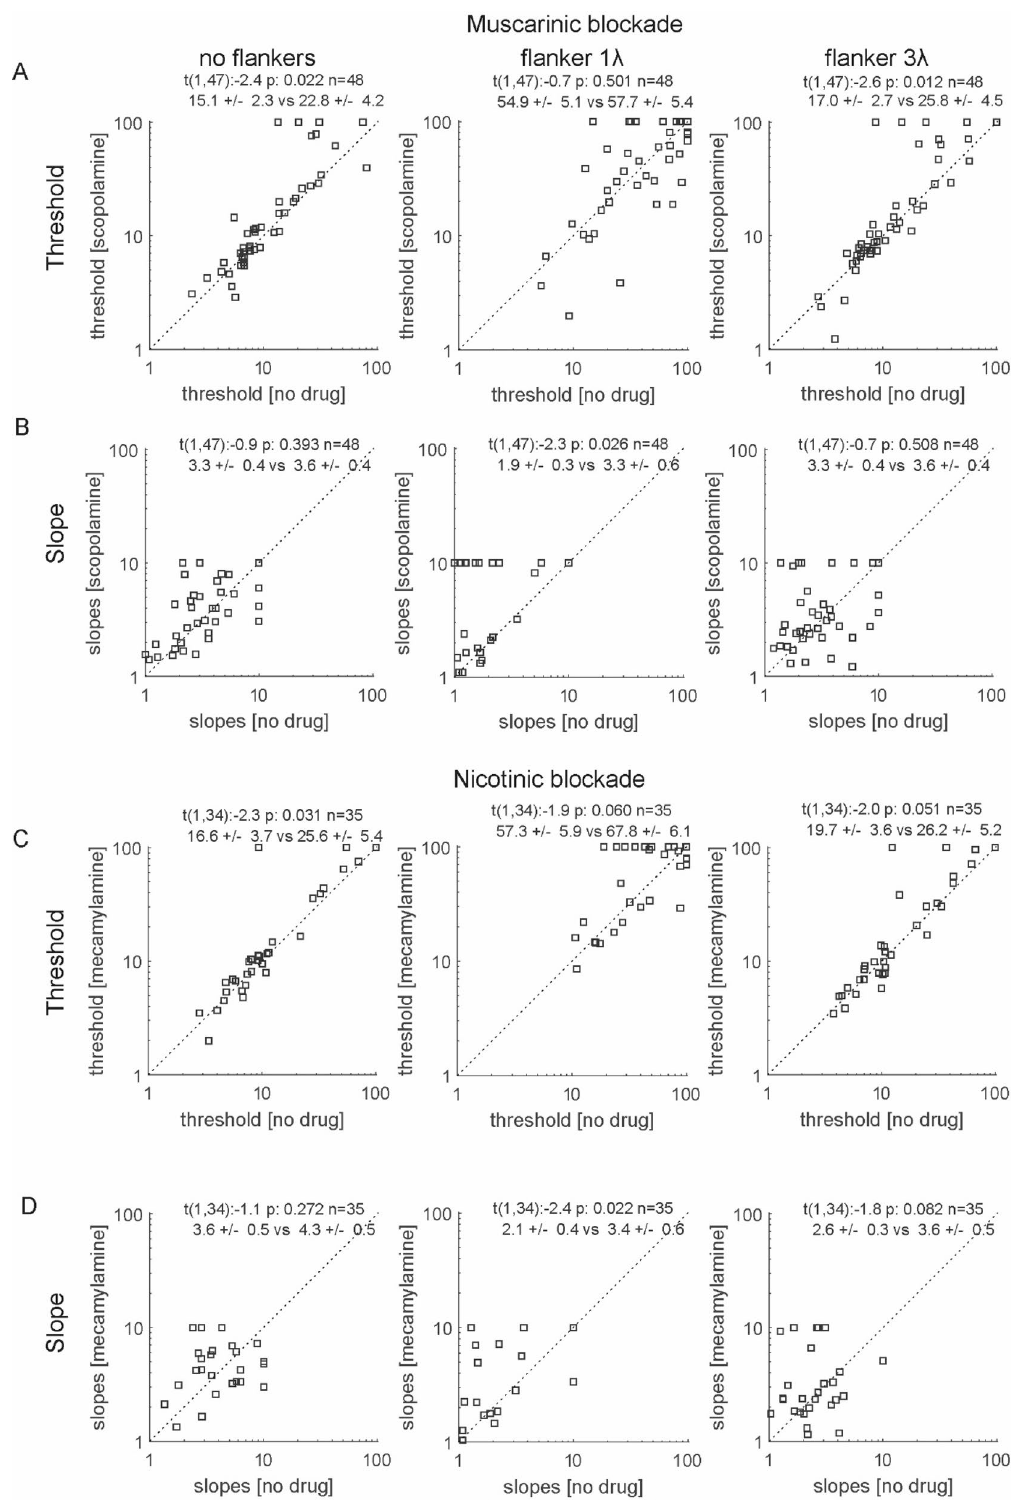
Figure 5. Effect of muscarinic and nicotinic blockade on neuronal thresholds and slopes at the population level for different flanker conditions. ( A ) Scatterplot of thresholds in the no drug condition (x-axis) against scatterplot of threshold in the drug applied (scopolamine) condition (y-axis). Left column shows results when no flankers were presented, middle column results for the flanker of 1λ, and right column shows results for the flanker of 3λ condition. Insets show paired t-test statistics along with the respective means ± S.E.M. of the distributions. ( B ) Same as A , but with slope instead of threshold as variable of interest. ( C,D ) same as A and B , but with mecamylamine instead of scopolamine